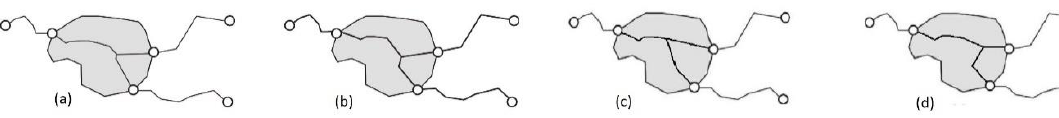
Figure 6. Elimination of loops from a skeleton: ( a ) skeleton with a loop; ( b ) the loop is replaced with the loop centroid (type 3 triangle); ( c ) the skeleton is modified with the use of network analysis tools; ( d ) the resulting skeleton where the loop was replaced with the loop centroid.